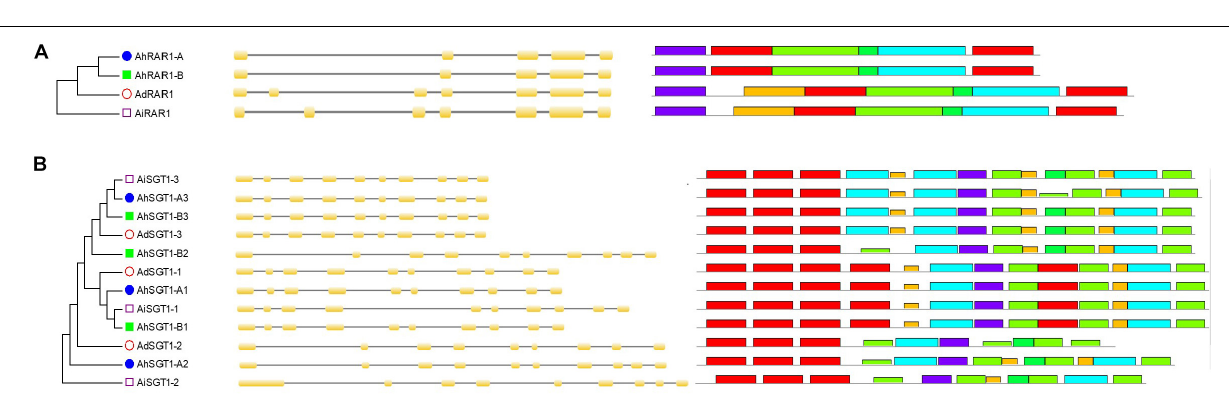
were significantly upregulated, and AhHSP90-A6 , AhHSP90-A8